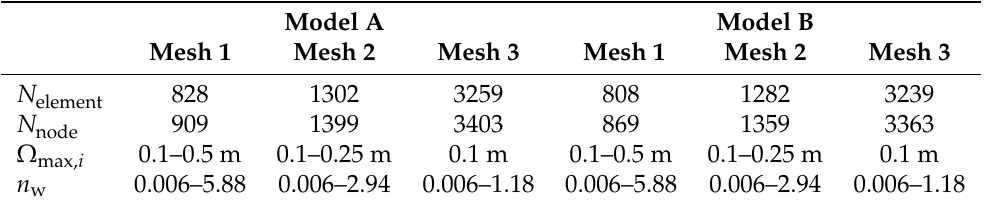
Figure 3. Meshes of Model A used for the PW-FEM: ( a ) Mesh 1, ( b ) Mesh 2, and ( c ) Mesh 3. Table 2. Detailed information of the used meshes for the PW-FE